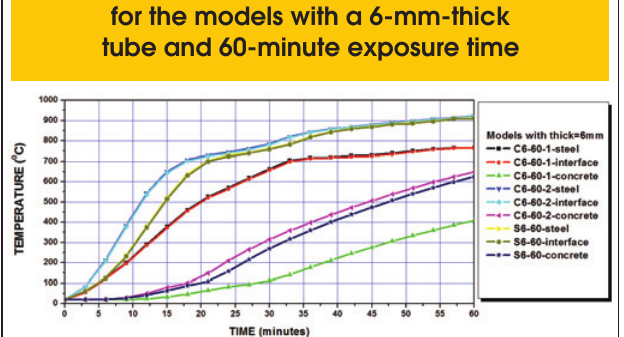
Figure 19 – Temperature elevation curves for the models with a 6-mm-thick tube and 60-minute exposure